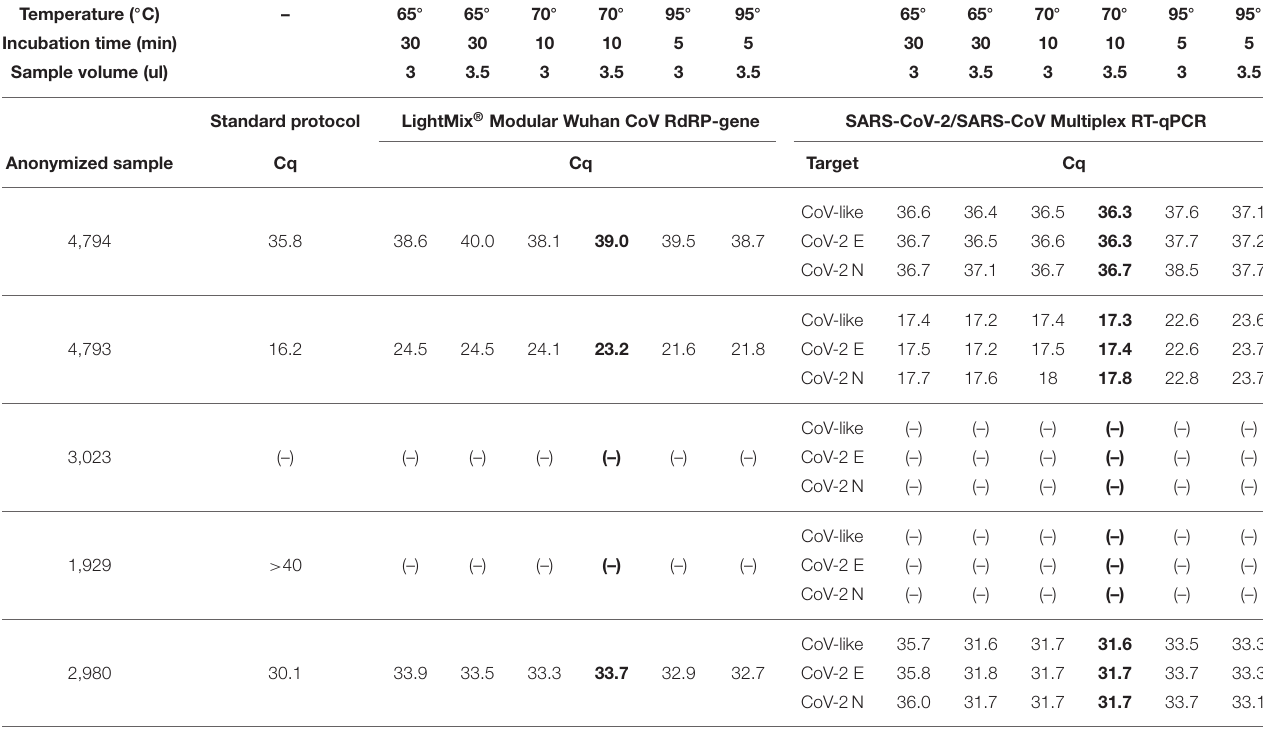
TABLE 1 | Result of the standardization of optimal conditions for direct